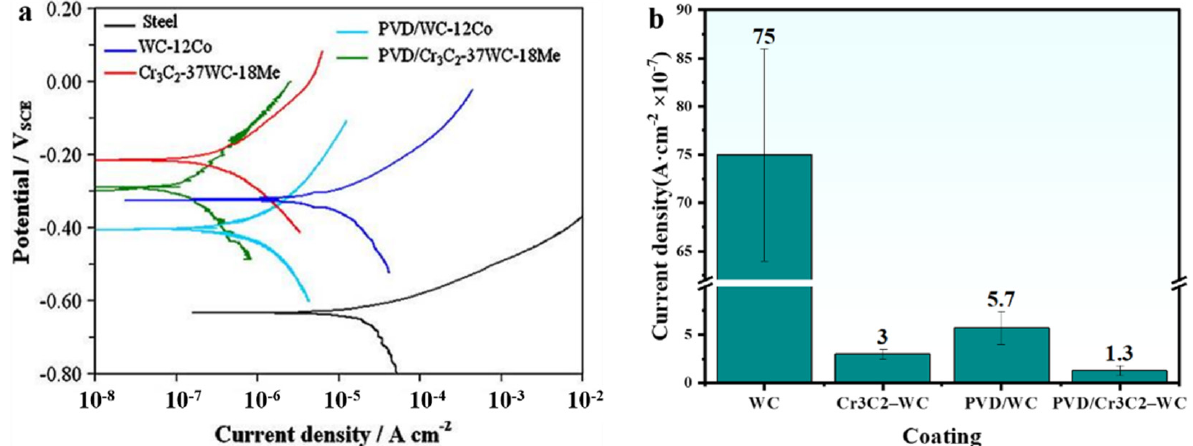
Figure 11. ( a ) Polarization curves and ( b ) corrosion current density of the steel substrate and coating samples in 3.5% NaCl solution. Reprinted with permission from Ref. [75]. Copyright Elsevier,